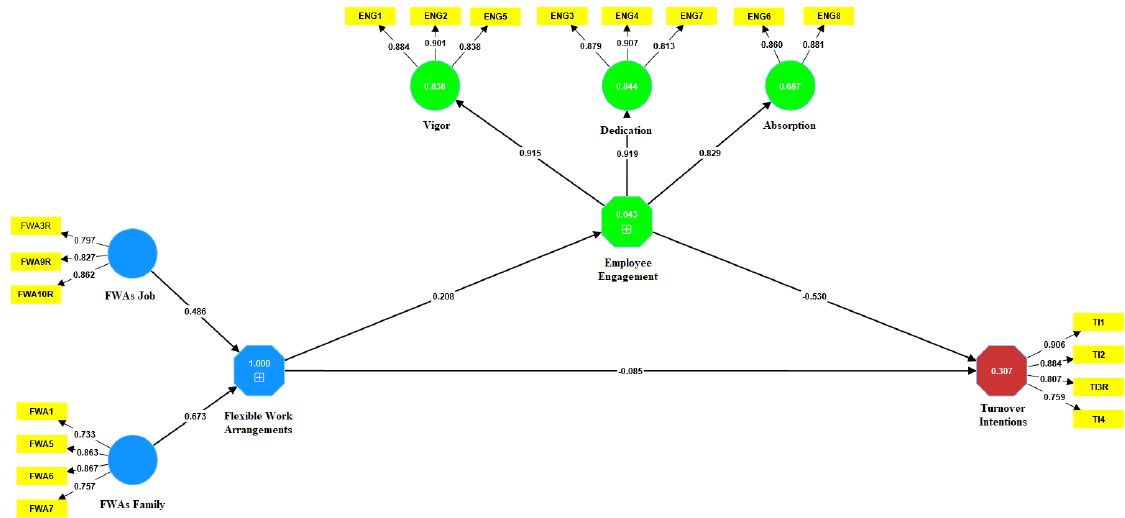
Figure 1. Path coefficient estimates. Source: The authors’ research. Table 7 represents the indicator and construct reliability test. The authors tested Cronbach’s alpha, composite reliability, and average variance extracted (AVE). Cronbach’s alpha values were 0.681, (absorption), 0.772 (flexible work arrangements job), 0.819 (flex- ible work arrangements family), 0.834 (dedication), 0.846 (vigor), and 0.861 for turnover